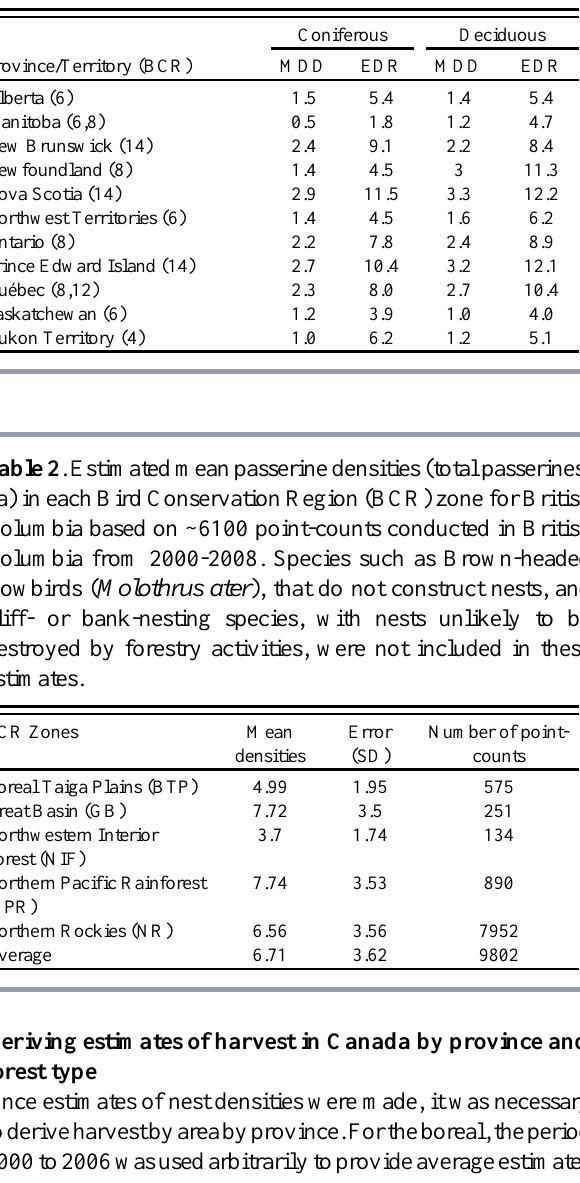
Table 1 . Estimates of passerine density based on singing males (males/ha) that were used to determine nest density by using regression-based estimates of mean counts converted to densities using maximum detection distance (MDD) and effective detection radius (EDR) based on distance sampling (see Methods), shown by forest type and province (excluding British Columbia). Number of Bird Conservation Regions (BCR) involved in commercial forest areas are given in parentheses. When two BCR values appear, the density estimates were based on the average of the two. Density estimates are derived from BAM point-count data available